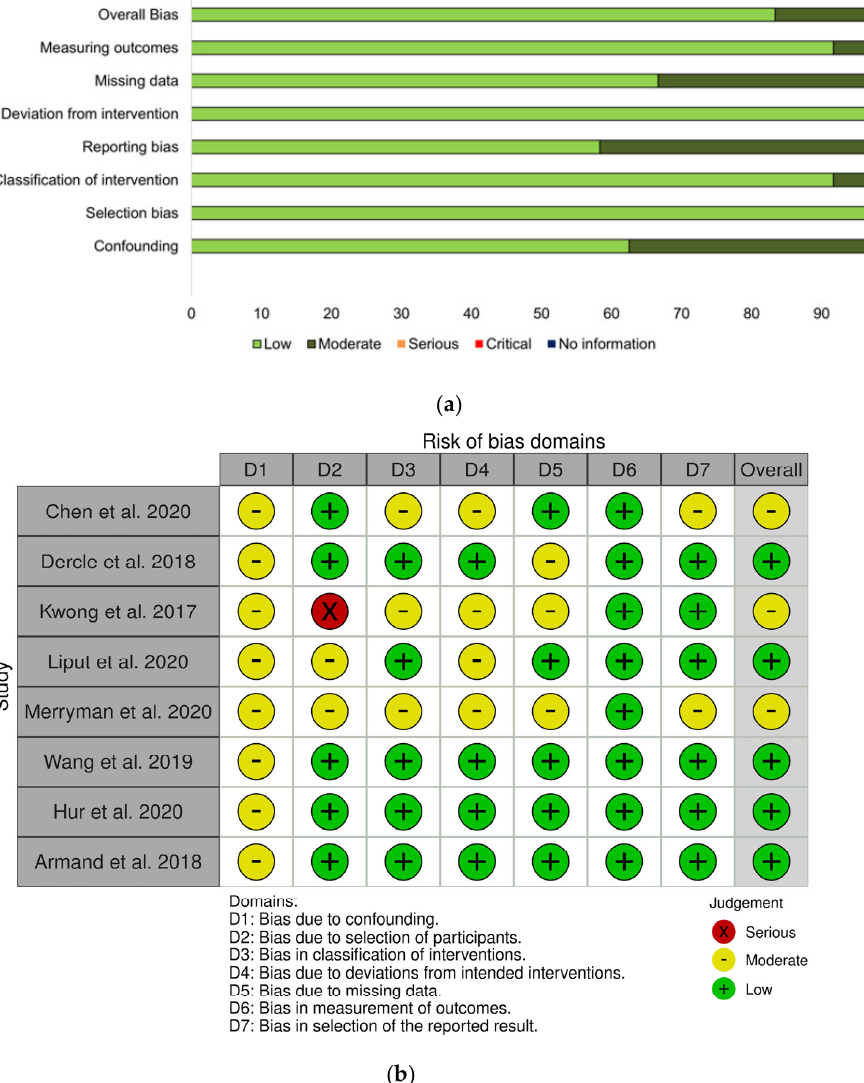
Figure 2. Risk of Bias in Nonrandomized Studies of Intervention (ROBINS-I) for Quality Assessment. ( a ) Distribution of risk of bias results within each bias domain; ( b ) description of the domain level results for each study.